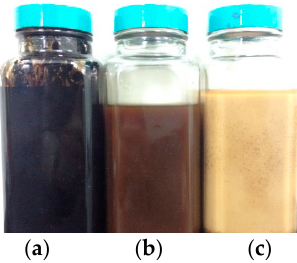
Figure 1. ( a ) Oily phase; ( b ) aqueous phase; and ( c ) emulsion of 5% FPBO + 95% diesel (FPBO = 50 vol % oily-phase oil + 50 vol % aqueous-phase oil). FPBO: fast pyrolysis